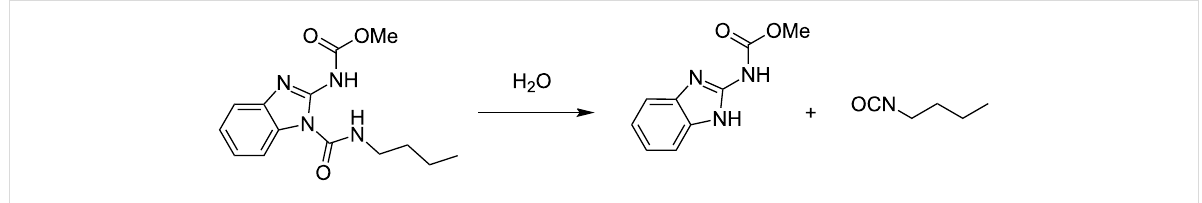
Figure 3: Chemical structure of